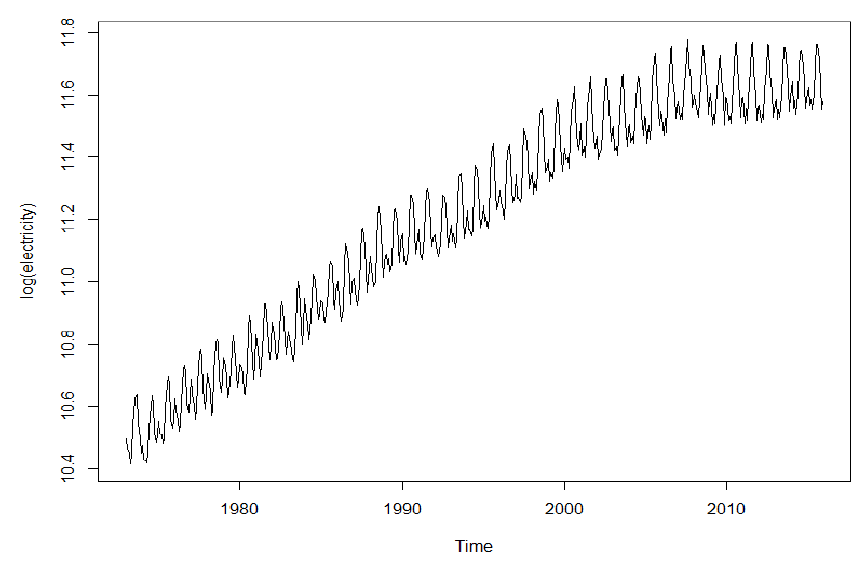
Figure 2. The ln (electricity data) from January 1973 to January 2016.